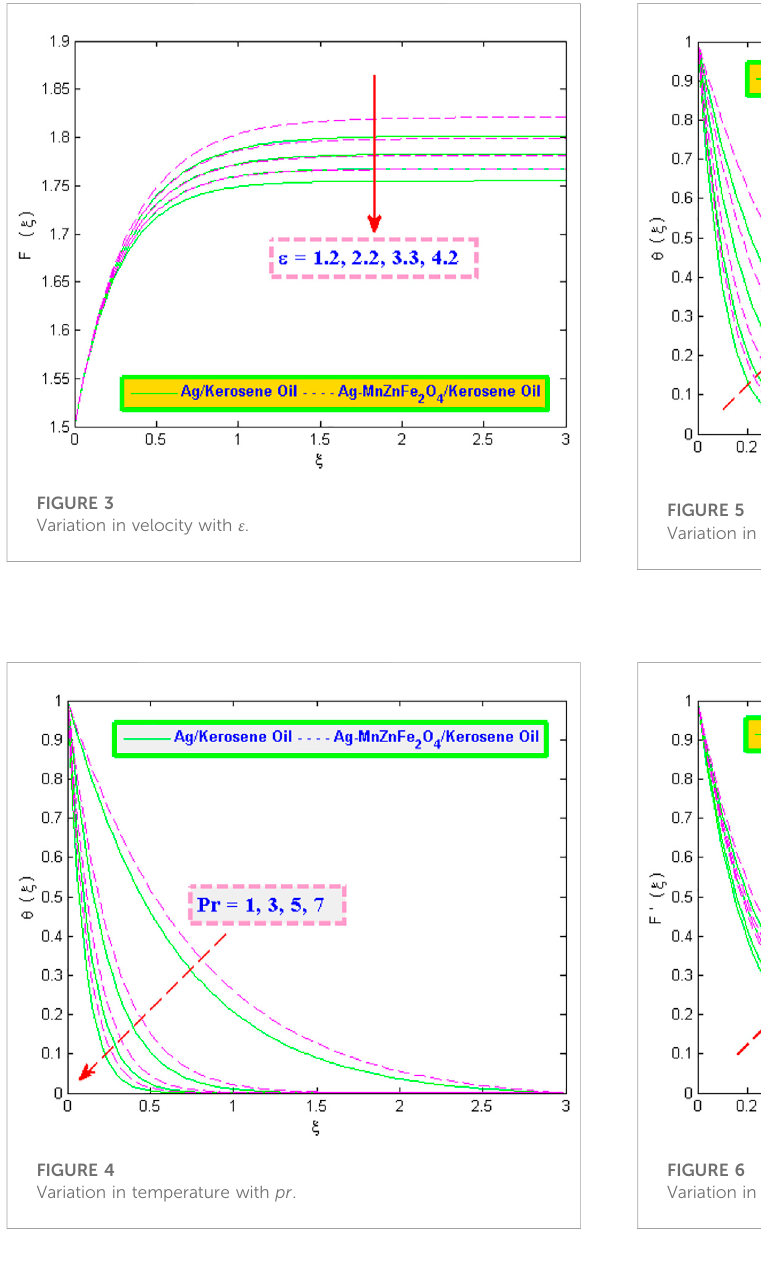
FIGURE 4 Variation in temperature with pr .